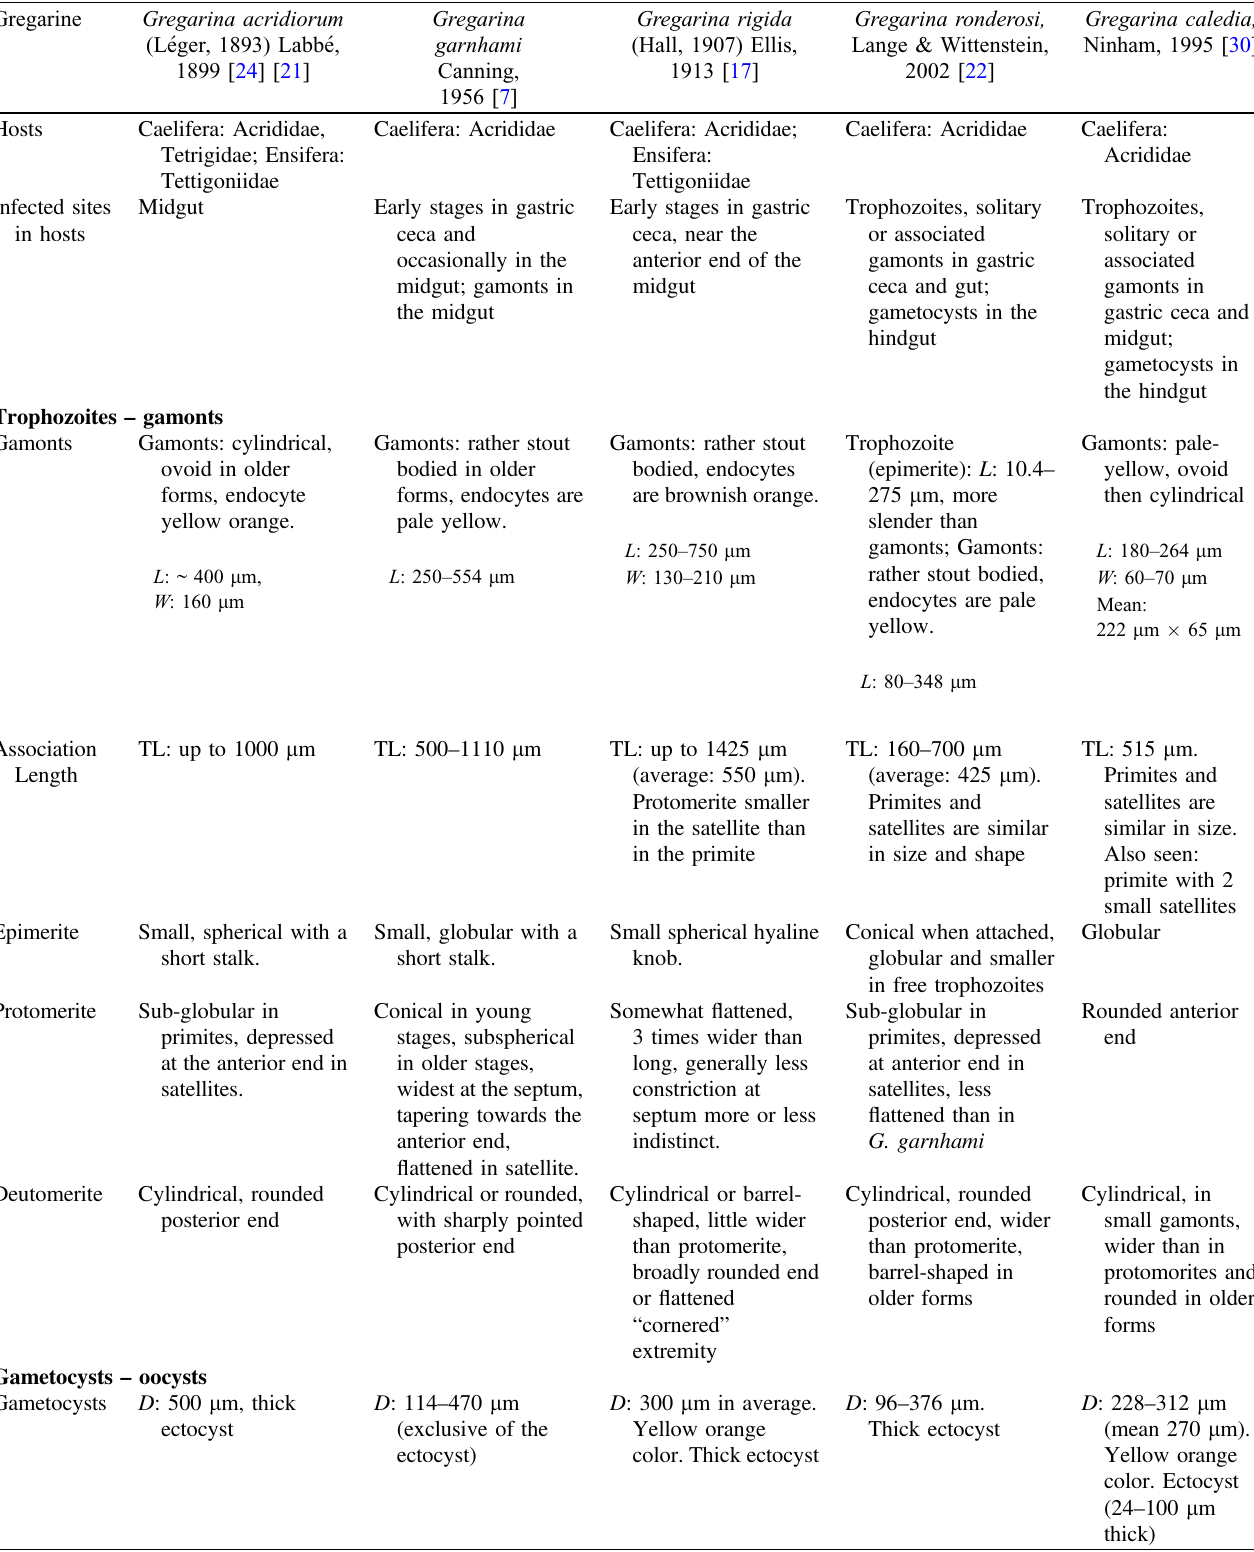
Table 1. Morphological differences between fi ve very similar gregarines of acridians reported in the literature. This table is based on individual descriptions provided by the authors of [7, 21, 22, 24, 30]; see also [17]. D , diameter; L , length; W , width; TL, total